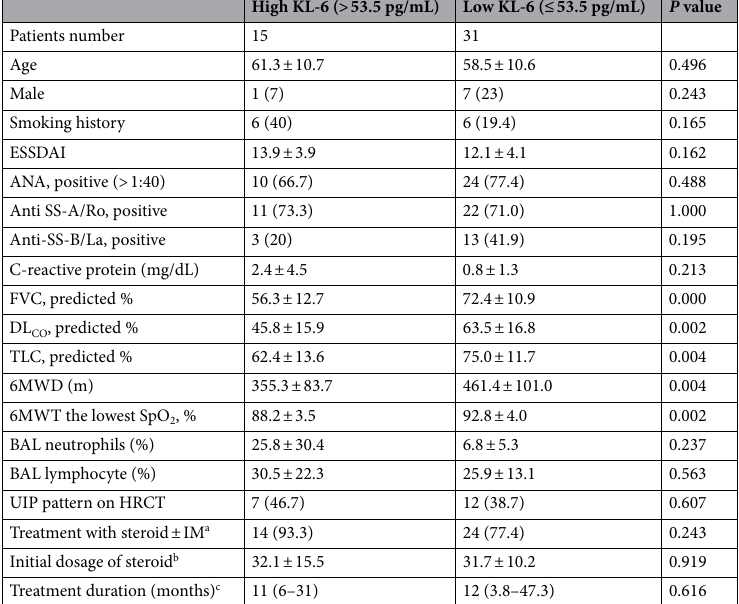
Table 5. Comparison between the clinical characteristics for high and low KL-6 groups in patients with SJS-ILD. Data are presented as mean ± standard deviation or number (%), unless otherwise indicated. a The six-minute walk test distance, 6MWT the lowest SpO2 lowest oxygen saturation during the six-minute walking test, ANA anti-nuclear antibody, BAL bronchoalveolar lavage, DL CO diffusing capacity of the lung for carbon monoxide, ESSDAI European Alliance of Associations for Rheumatology Sjögren’s Syndrome Disease Activity Index, FVC forced vital capacity, HRCT high resolution computed tomography, ILD interstitial lung disease, KL-6 Krebs von den Lungen-6, SJS Sjögren syndrome, TLC total lung capacity, UIP usual interstitial